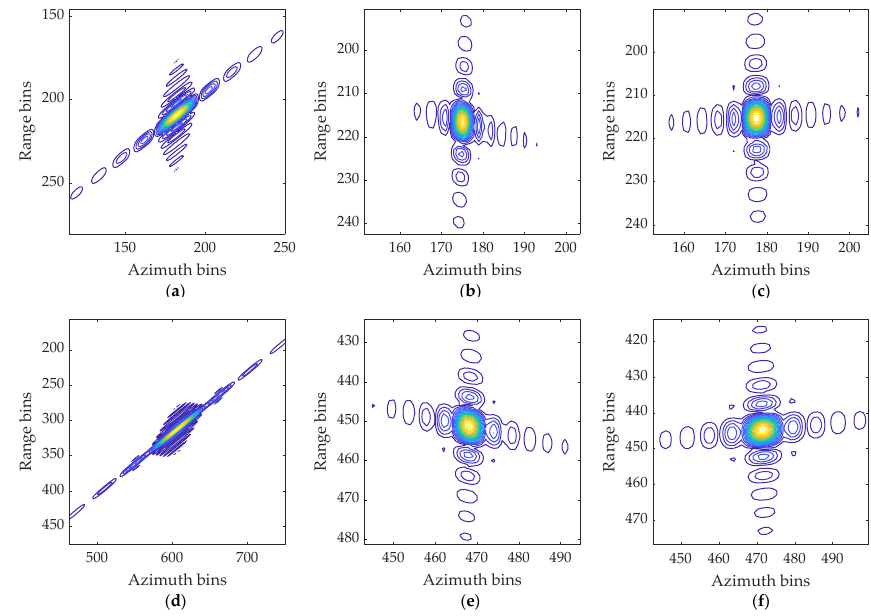
Figure 12. Moving target focused image and sparse enhancement image with or without spectrum rotation: ( a ) Focused image without spectrum rotation; ( b ) Focused image with SASR; ( c ) Focused image with ESASR; ( d – f ) Sparse enhancement image of ( a – c ), respectively.